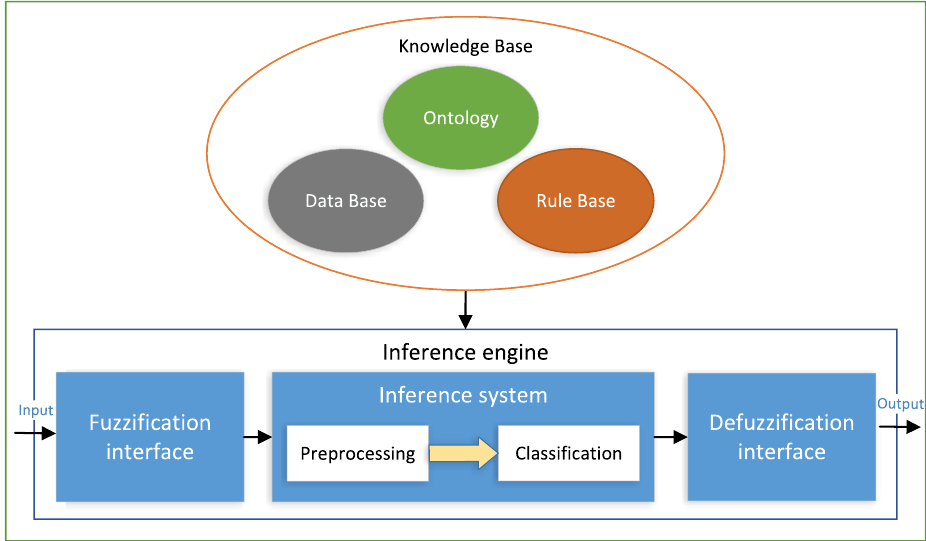
Figure 1. Structure of the proposed classification